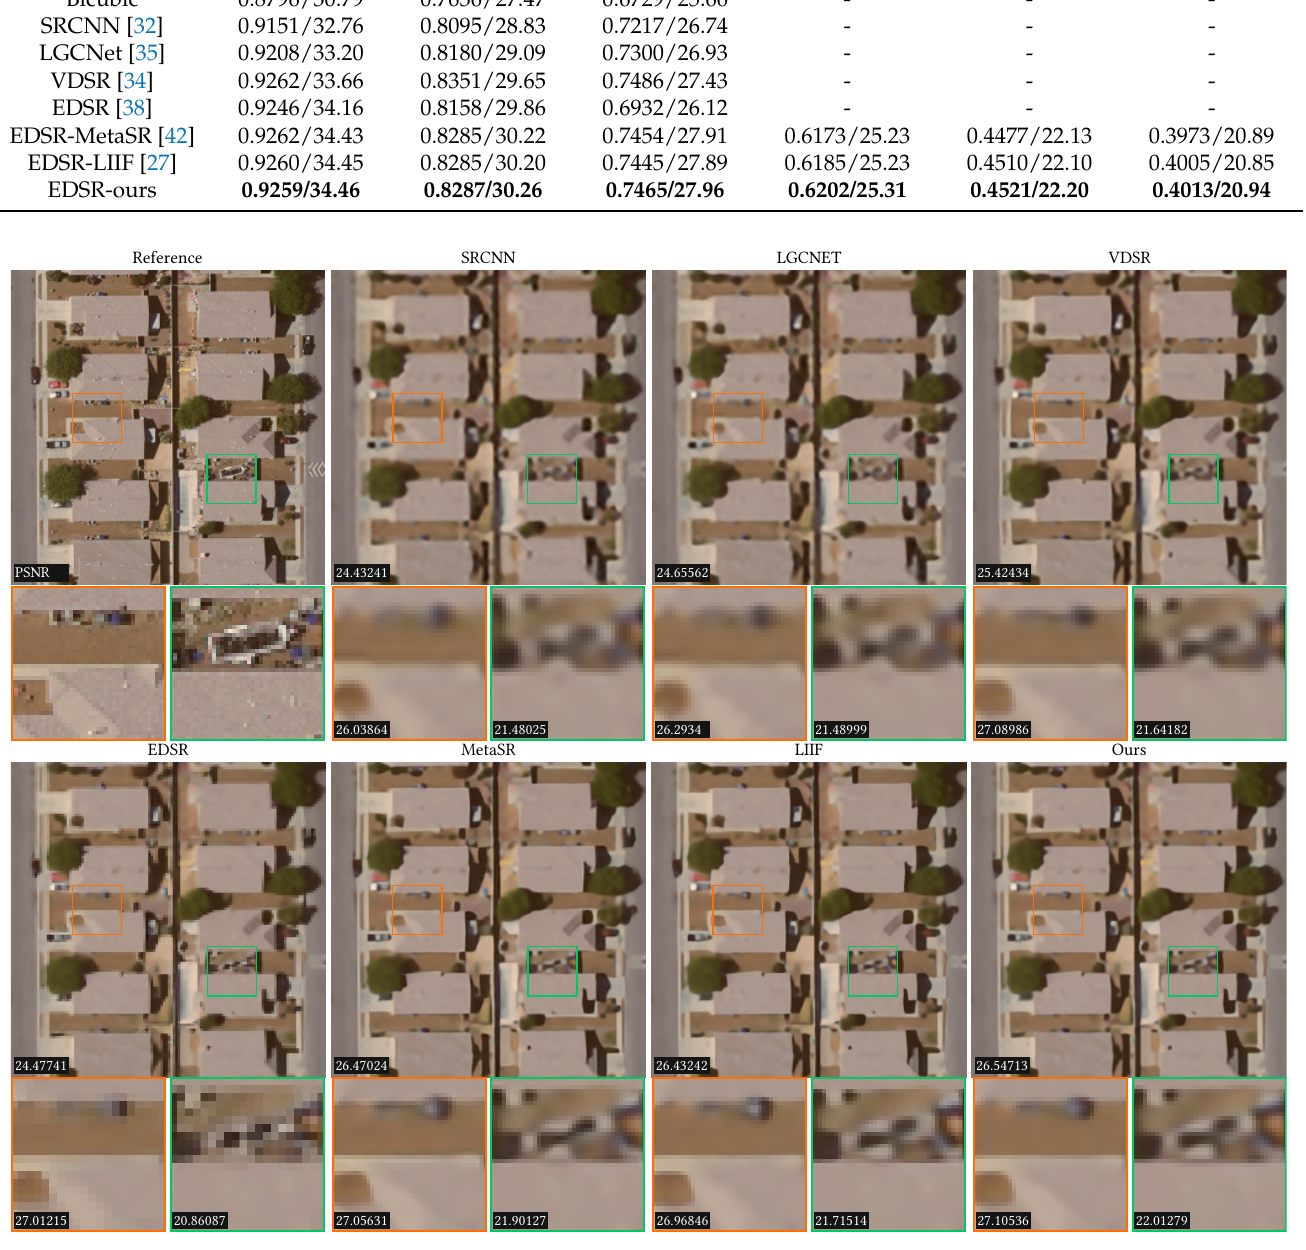
Figure 6. Comparison results of the × 4 scale on the dense residential_88 scene of the UC Merced dataset. Two local regions are zoomed in to show the detailed results. The PSNR values are listed in the bottom-left